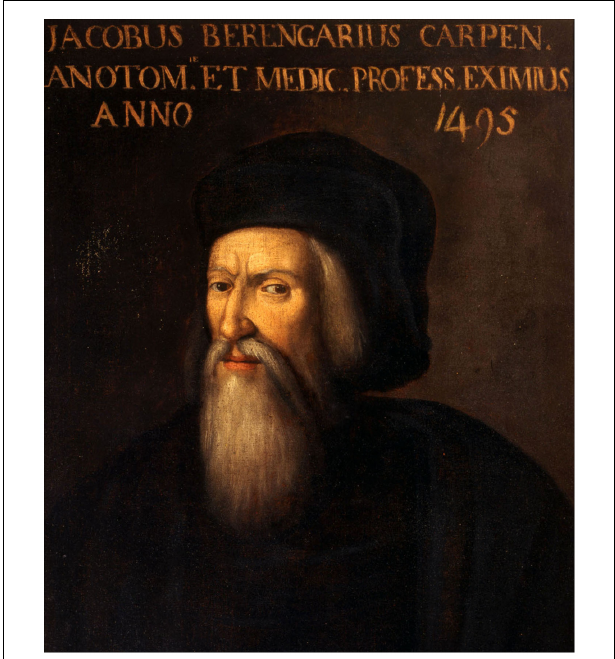
FIGURE 1 | A portrait of Berengario da Carpi from a 16th-century-painter known only by his initials (F. E.). The indication “ Anno 1495 ” above the portrait sheds doubt on the identity of the personage illustrated here. At the end of the 15th century, Berengario would have been around 35–40 years of age, whereas the painting shows a rather old man wearing a long beard. Nevertheless, the highly determined and yet ambiguous look of the personage could have been part of Berengario’s physiognomy. The painting is currently displayed in the Museum of the beautiful Palazzo dei Pio, at Carpi, Province of Modena (Courtesy of the Museo municipale , Carpi,